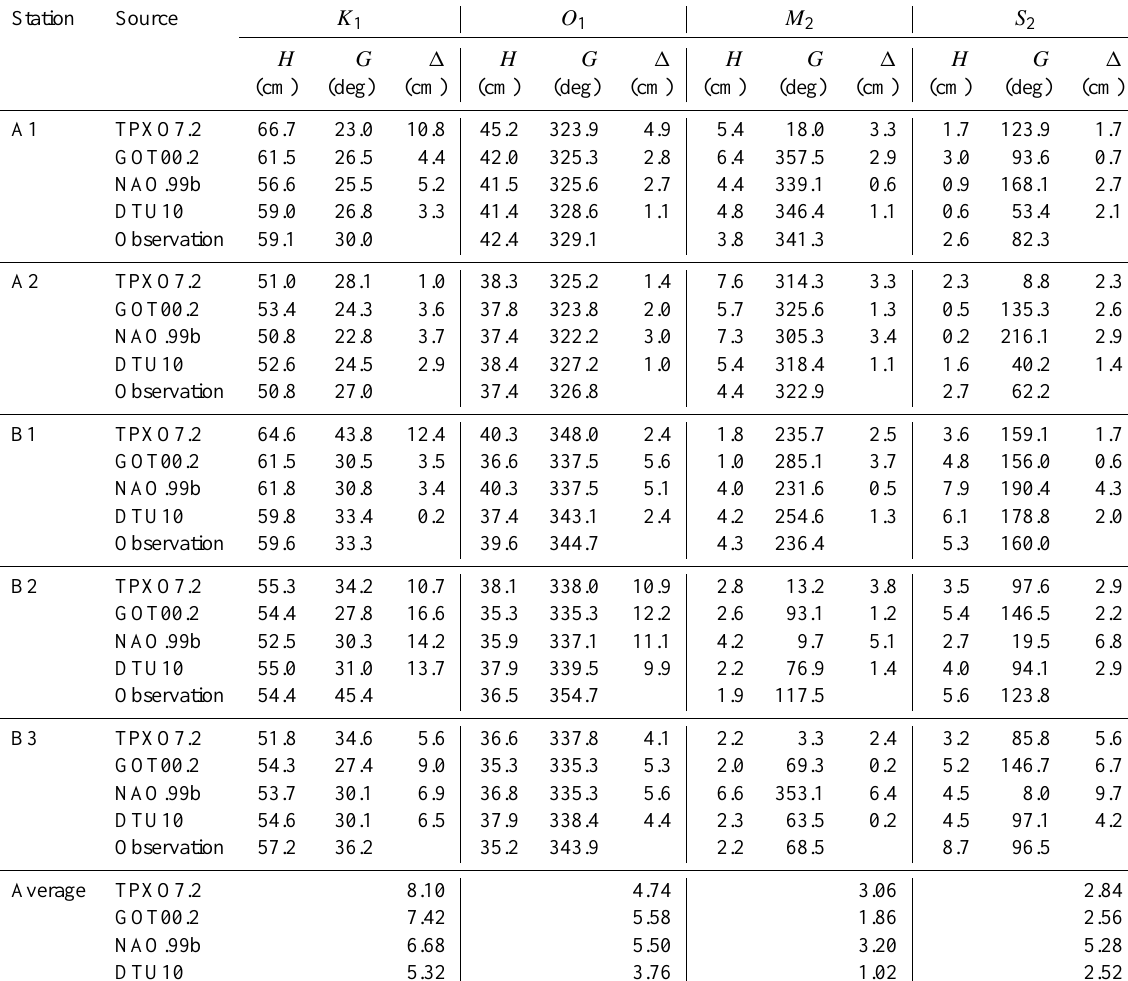
Table A1. Comparison between four tidal models and